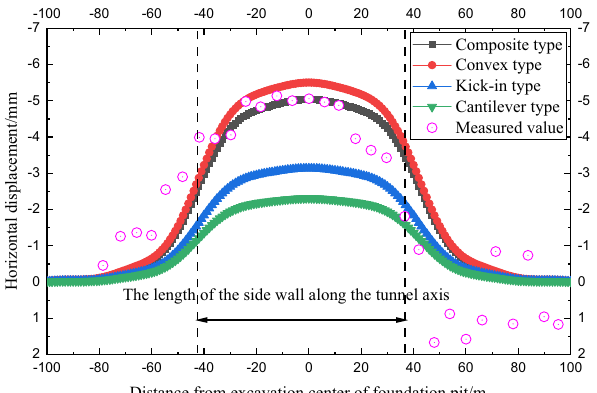
Figure 15. Comparison of tunnel deformation caused by different deformation modes of retaining structure (case